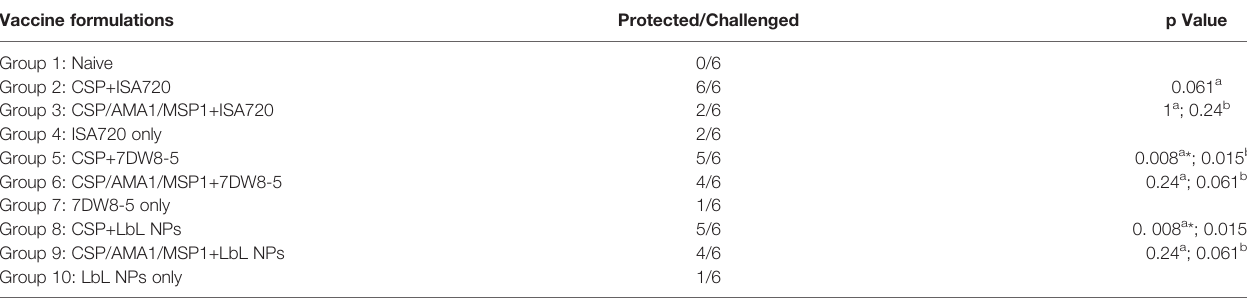
TABLE 4 | Protection of mice immunized with vaccine candidates against transgenic PfCSP/Py sporozoites administrated intravenously. Vaccine